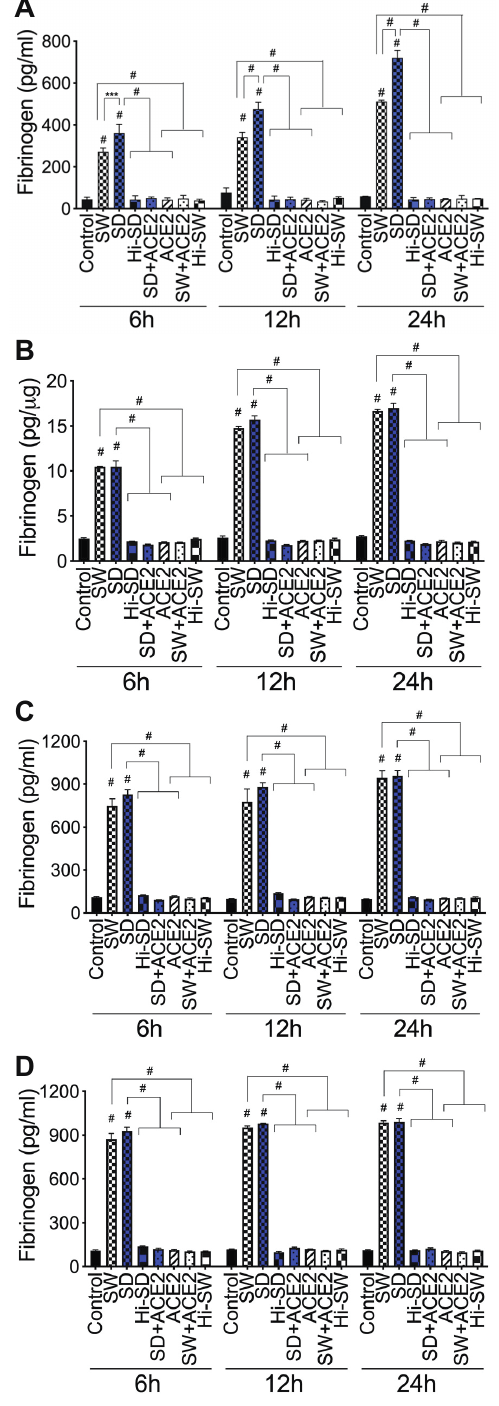
Figure 5. S-proteins and endothelial–neutrophil interactions induce fibrinogen expression and release in HLMEC. ( A , B ) HLMEC treated with S-proteins (1 nM SW or SD) for 6–24 h; ( C ) HLMEC treated 6 h with S-proteins, washed, and co-cultured with neutrophils for 6–24 h; ( D ) neutrophils treated 6 h with S-proteins, washed, and co-cultured with HLMEC for 6–24 h. Following treatments, fibrinogen levels in culture supernatants ( A , C , D ) and endothelial cell lysates ( B ) were quantified by ELISA. Data presented as mean ± standard deviation. Control: untreated cells; Hi-SW: cells treated with 1 nM heat-inactivated SW; Hi-SD: cells treated with 1nM heat-inactivated SD; ACE2: cells treated with rhACE2 (1 µ g/mL). *** p = 0.0006; # p <